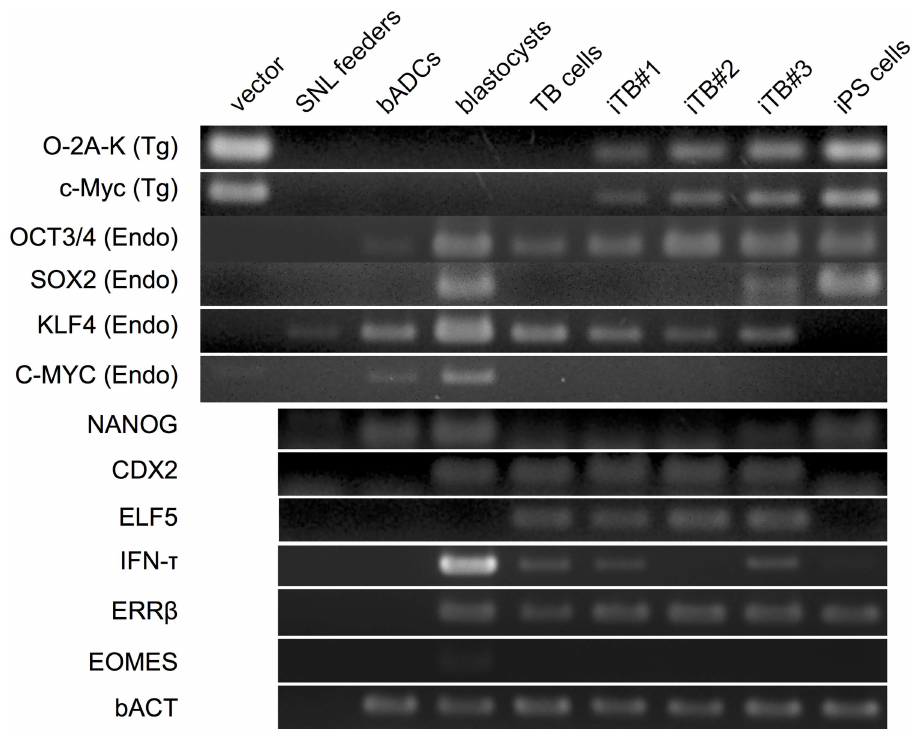
Fig 4. Endogenous and exogenous expression of genes related to pluripotent stem cells or trophoblast cells in bovine-induced trophoblastic cells (biTBCs). mRNA expressionwas evaluatedby reverse-transcriptionpolymerase chain reaction (RT-PCR). vector, plasmid DNA of PB vectors; SNL feeder, SNL feeder cells; bADCs, bovineamnion-derived cells; TB cells, trophoblast cells derivedfrom CT-1 cells; iTB#1, biTBC line #1; iTB#2, biTBC line #2; iTB#3, biTBC line #3; iPS cells, iPS cells derived under the iPS medium